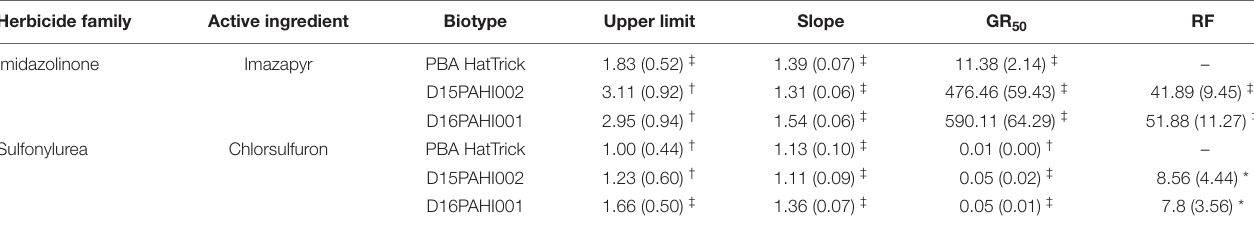
TABLE 4 | Estimated parameters – including resistance factor (RF) and 50% growth reduction (GR 50 ) values comparing the response of two mutant lines D15PAHI002 and D16PAHI001 to control cv. PBA HatTrick to the imidazolinone herbicide imazapyr or sulfonylurea herbicide chlorsulfuron. Herbicide family Active ingredient Biotype